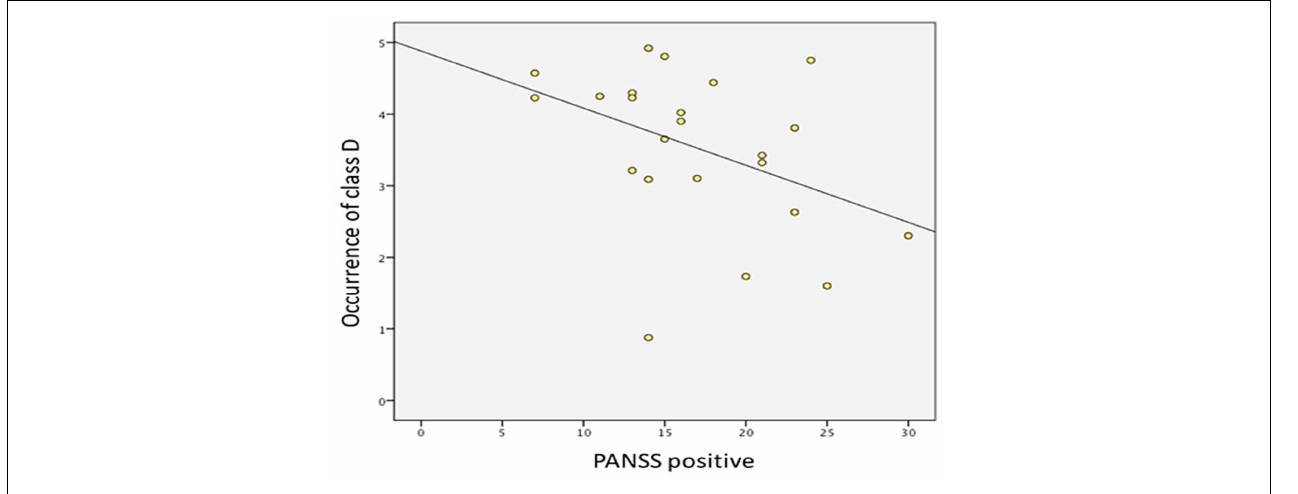
FIGURE 4 | Correlation between PANSS positive symptoms and the occurrence of microstate class D in drug-naïve, first-episode patients with schizophrenia.